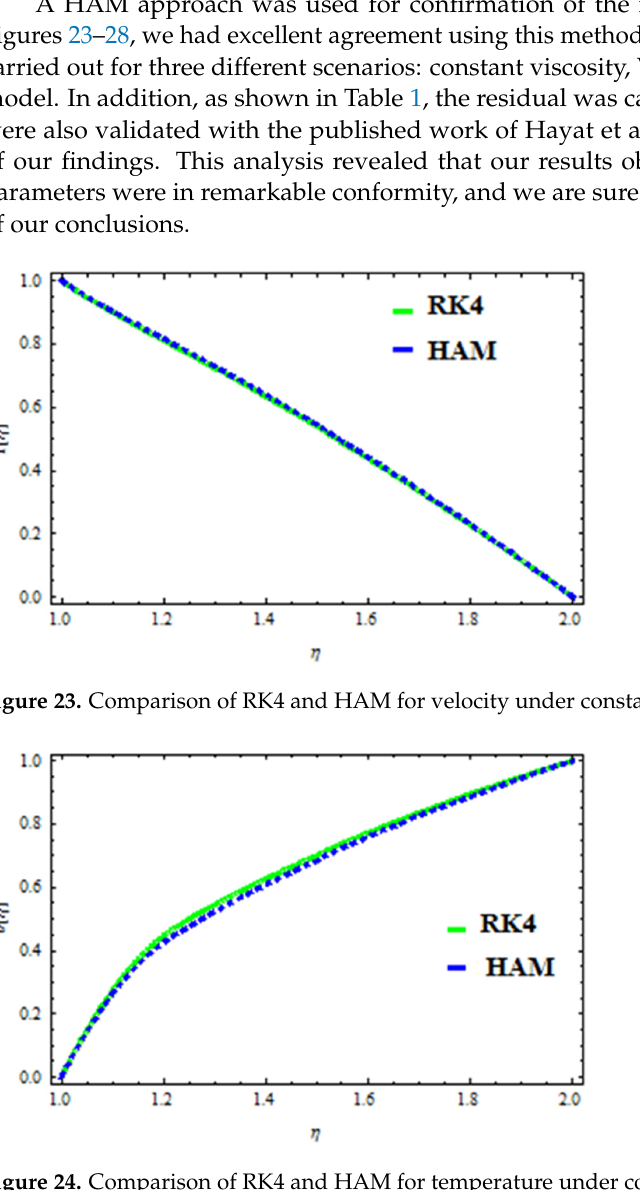
Figure 24. Comparison of RK4 and HAM for temperature under constant viscosity.